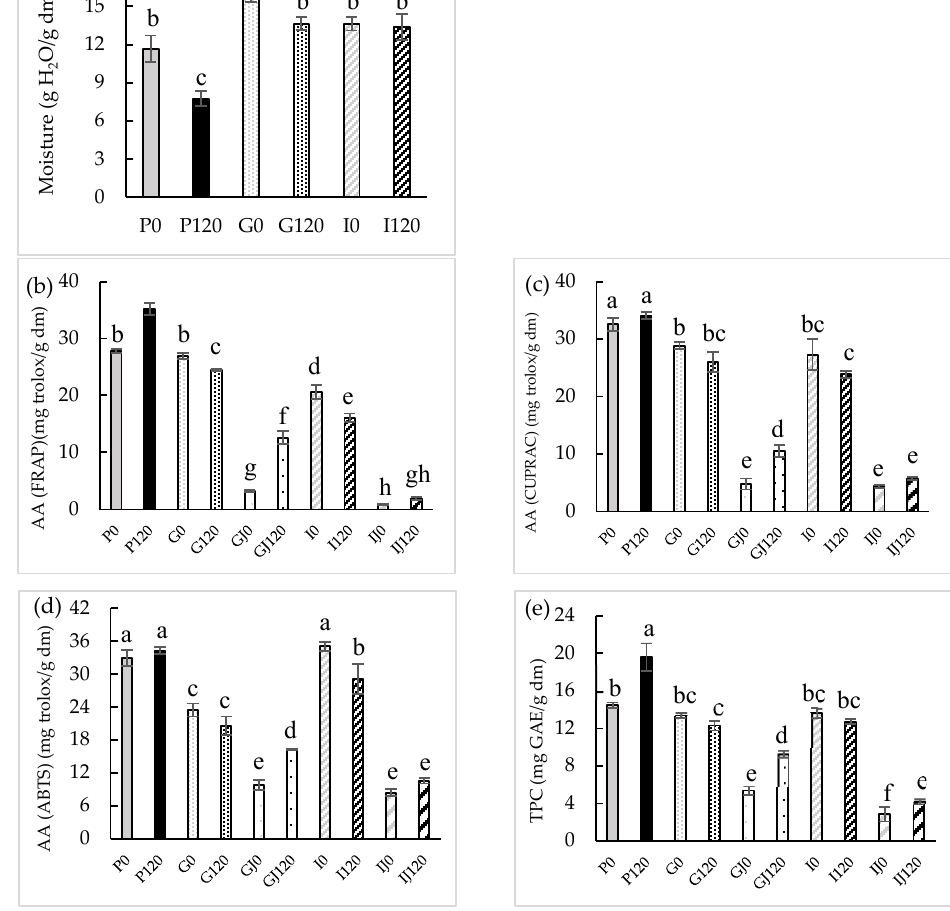
Figure 1. Moisture ( a ), antioxidant activity (AA) (FRAP ( b ), CUPRAC ( c ), and ABTS ( d ) assays) (mg Trolox/g dry matter) and total polyphenol contents (TPC) ( e ) before and after in vitro gastric (G) and intestinal (I) digestions in both solid and juice (J). Different letters for the same parameter indicate significant differences ( p < 0.05) among samples.